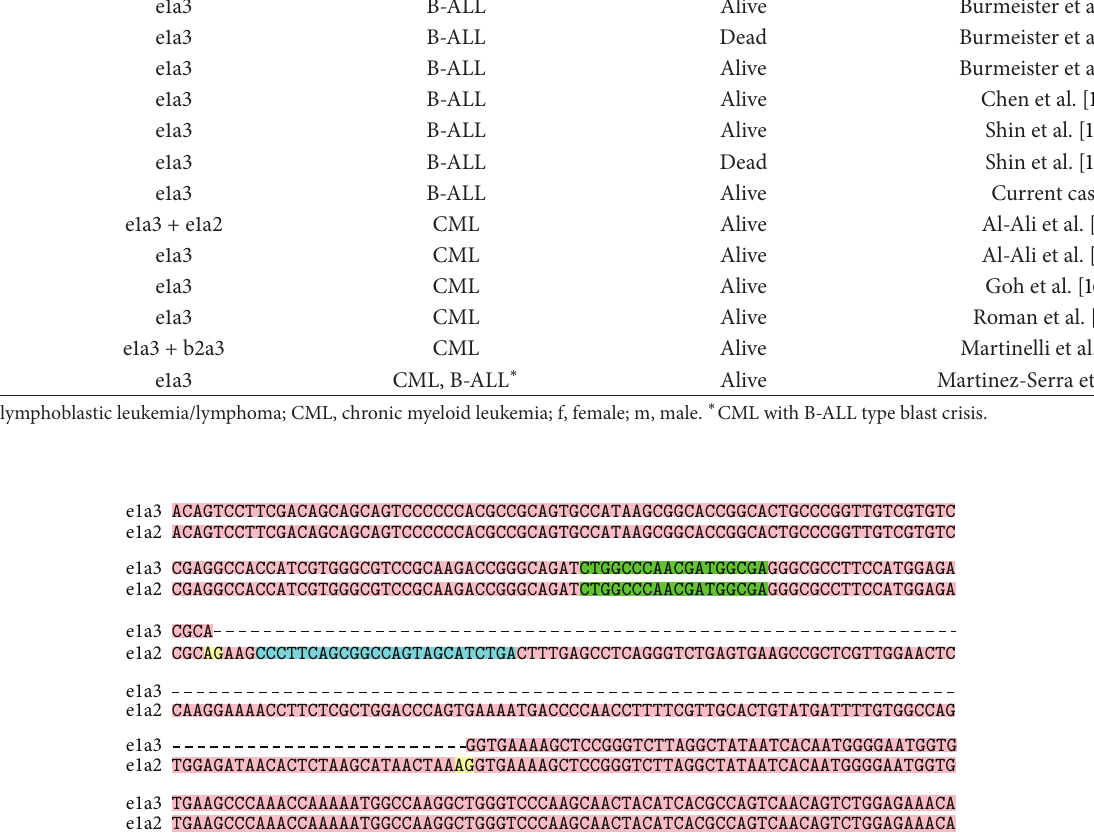
Figure 3: Sequence alignments between e1a2 (p190) and the variant e1a3 (p190) on a portion of the BCR-ABL1 sequence. Example of specific primers [6] (green and blue) used to detect e1a2 with the quantitative RT-PCR method. Notice that the exon a2 sequence (blue) is lacking in the e1a3 transcript, represented by the dotted line. The lack of this primer binding site sequence results in a negative BCR-ABL1 p190 result with the p190 quantitative PCR